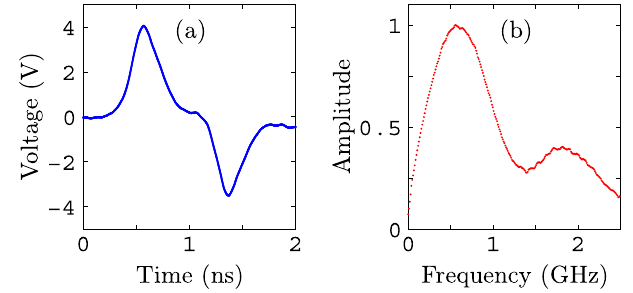
FIG. 5. Photograph of FONT5 stripline BPM P3 and its mover in the ATF2 beam line.